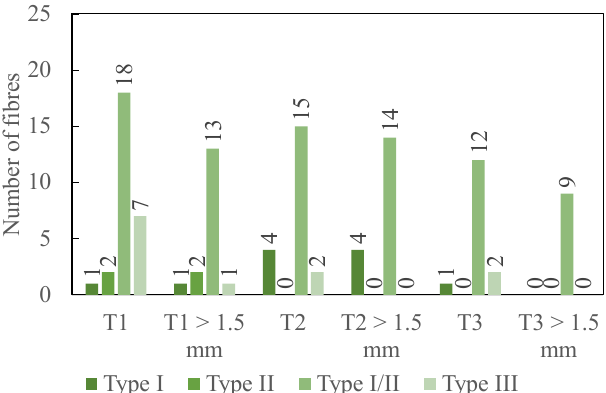
Figure 9. Experimental results: number of delaminated fibres (total and longer than 1.5 mm) after the up milling for 240 mm (2 coupons) at the fresh state-average values for one coupon.